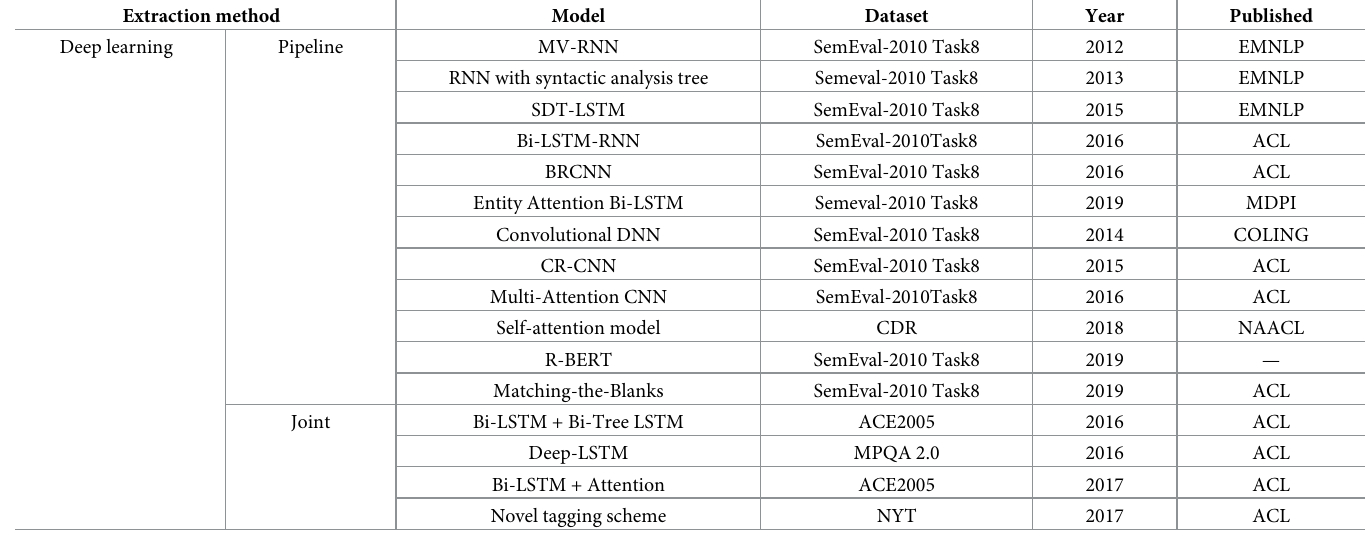
Table 3. The different models and datasets based on deep